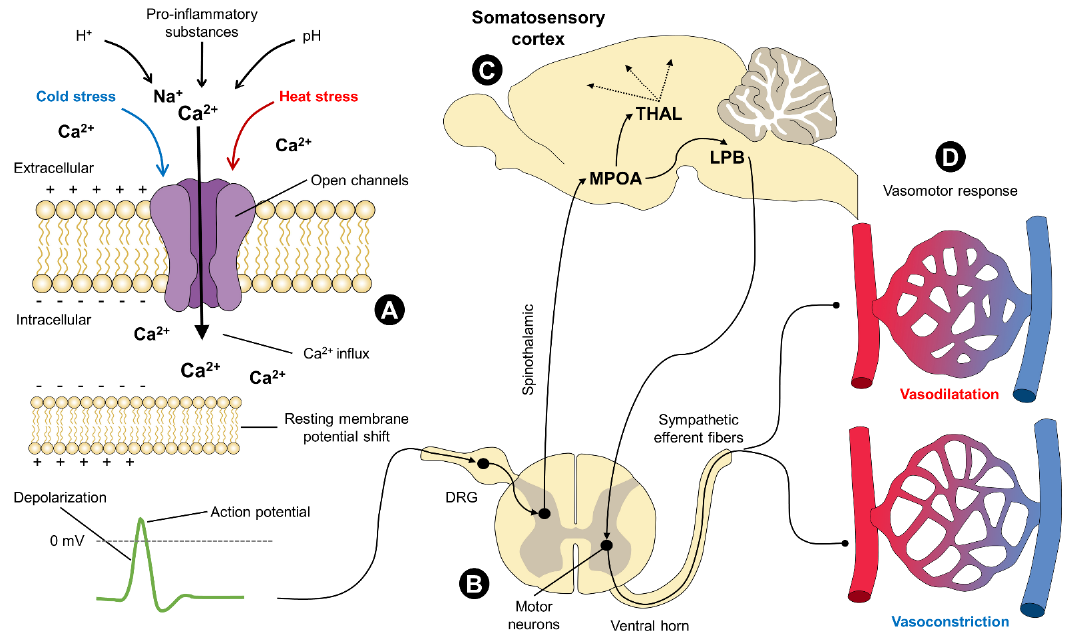
Figure 4. Activation and physiological participation of TRP channels in vasomotor thermoregulation. TRP receptors are channels permeable to Ca 2+ and other cations (Na + ). When they respond to